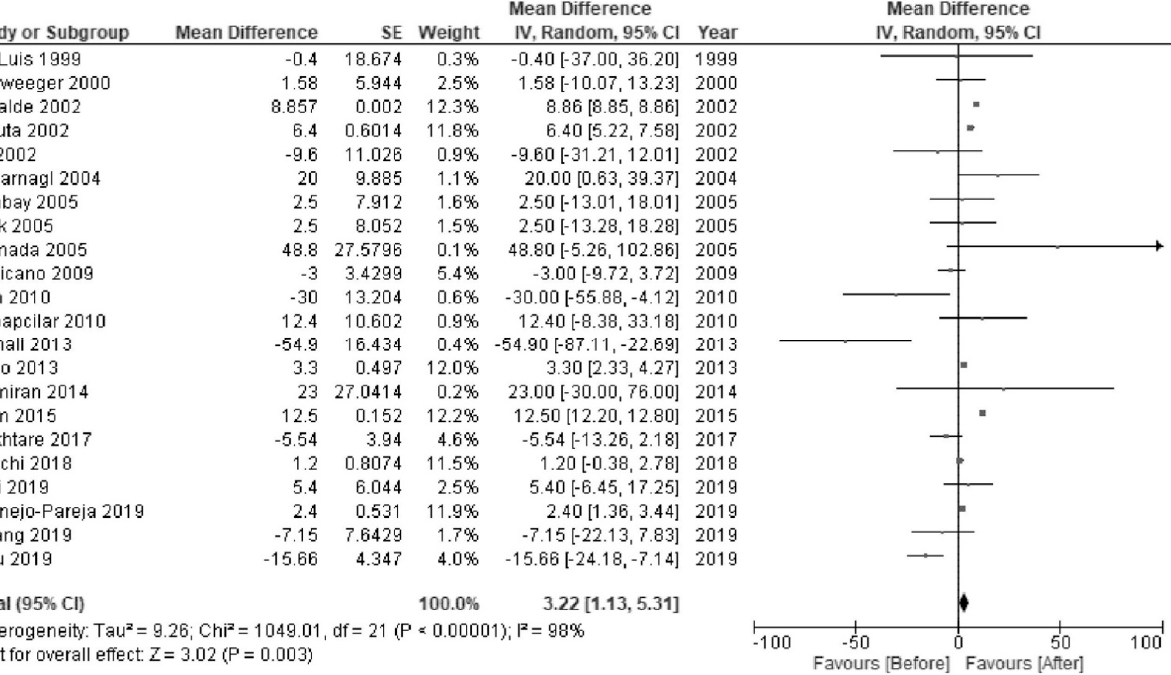
Figure 2. Forest plot of the mean changes in high-density lipoprotein cholesterol levels before and after Helicobacter pylori eradication.